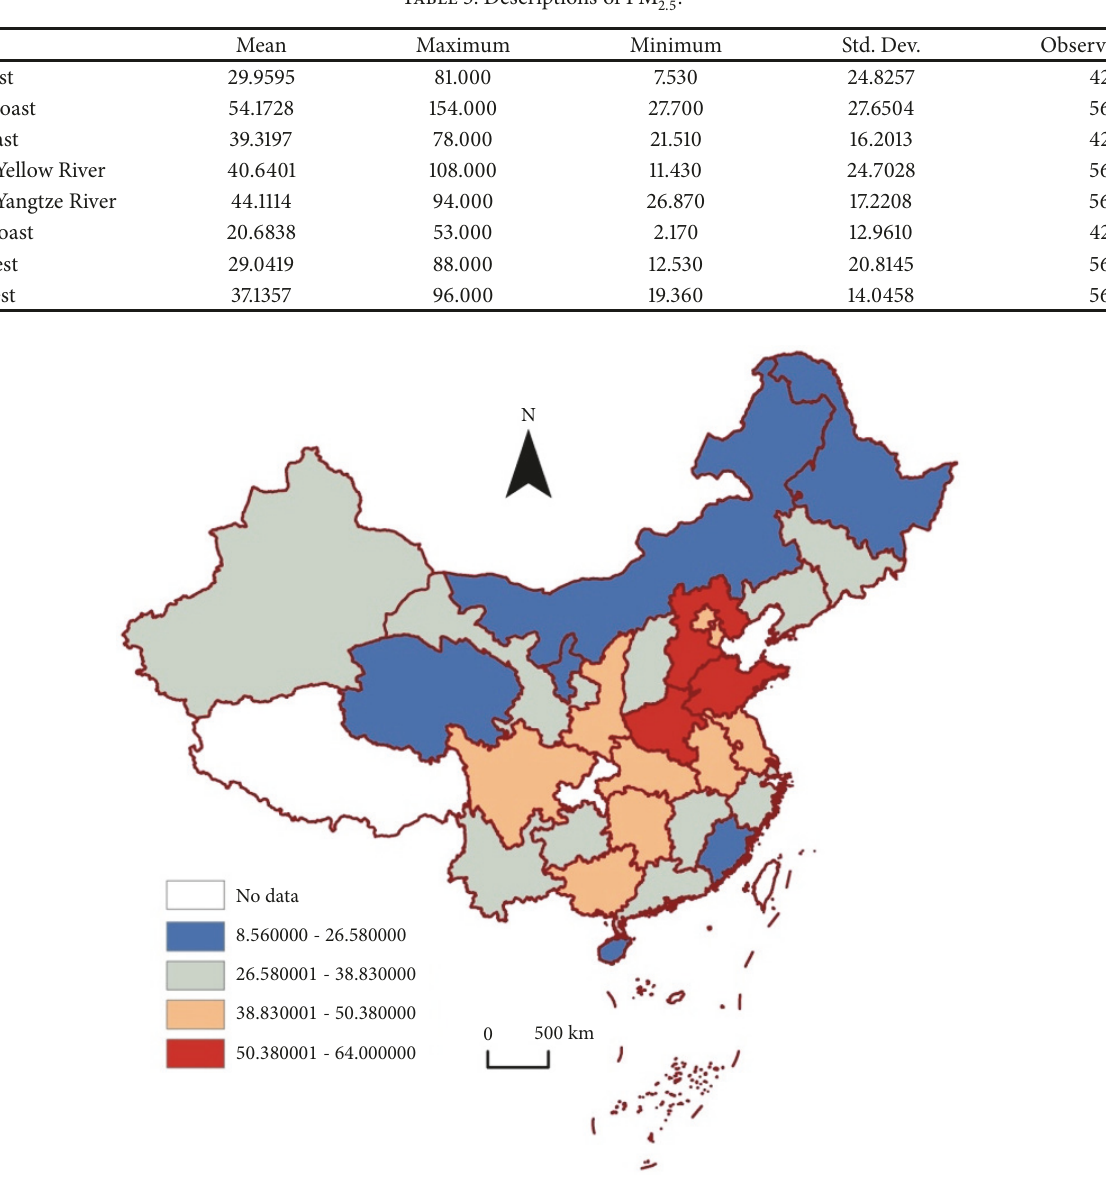
Table 3: Descriptions of PM 2.5 .